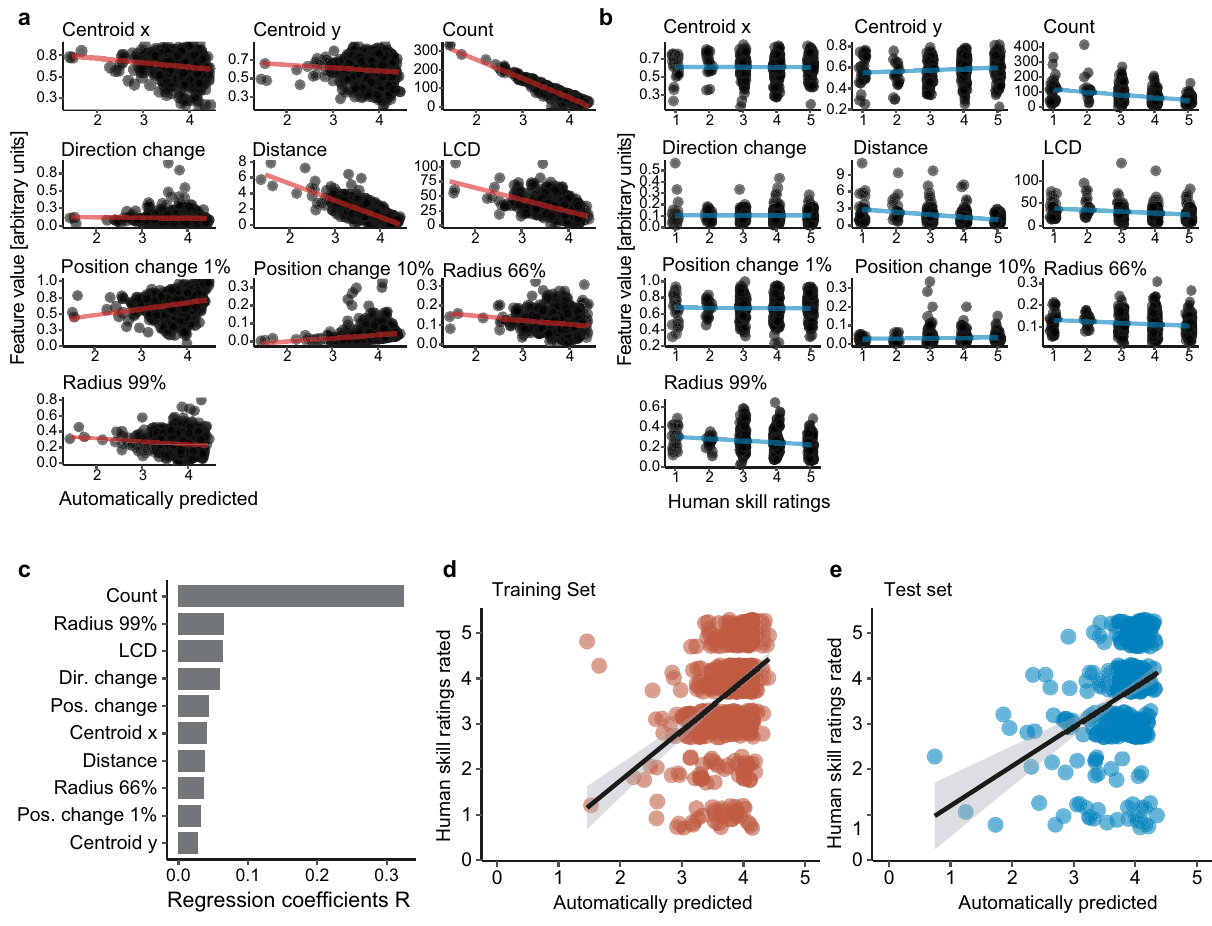
Figure 3. ( a ) Correlations (regression lines in red) of extracted motion features and automatically predicted skill rating in the training set. ( b ) Correlations (regression lines in blue) of extracted motion features and human skill rating in the test set. ( c ) Absolute regression coefficients R of the linear regression model to predict human skill ratings. Correlation of automatically predicted versus human rated skill ratings in the training set ( d ) and test set ( e